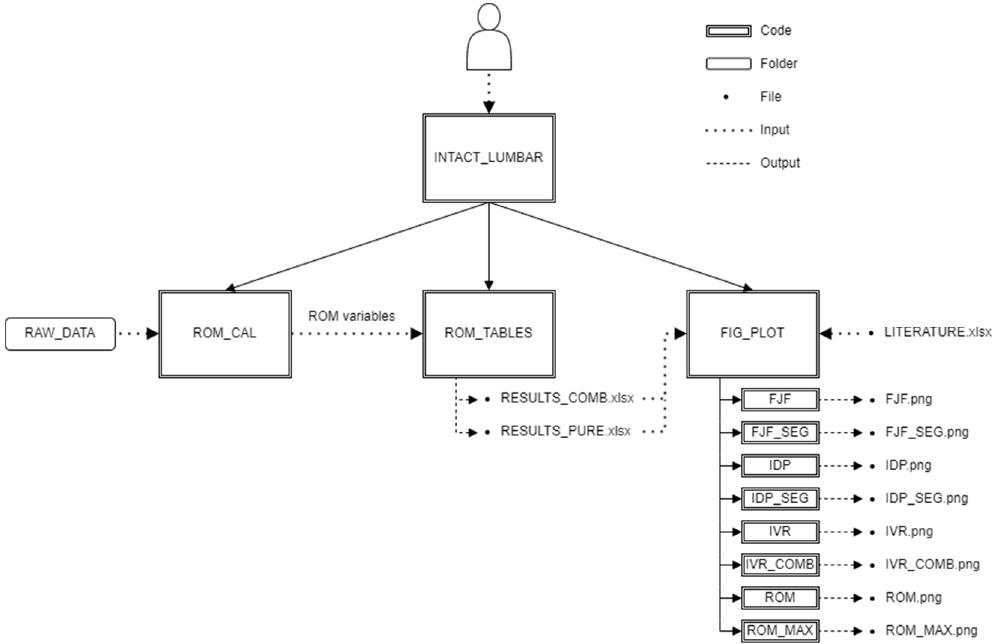
Figure A5. Code Structure.